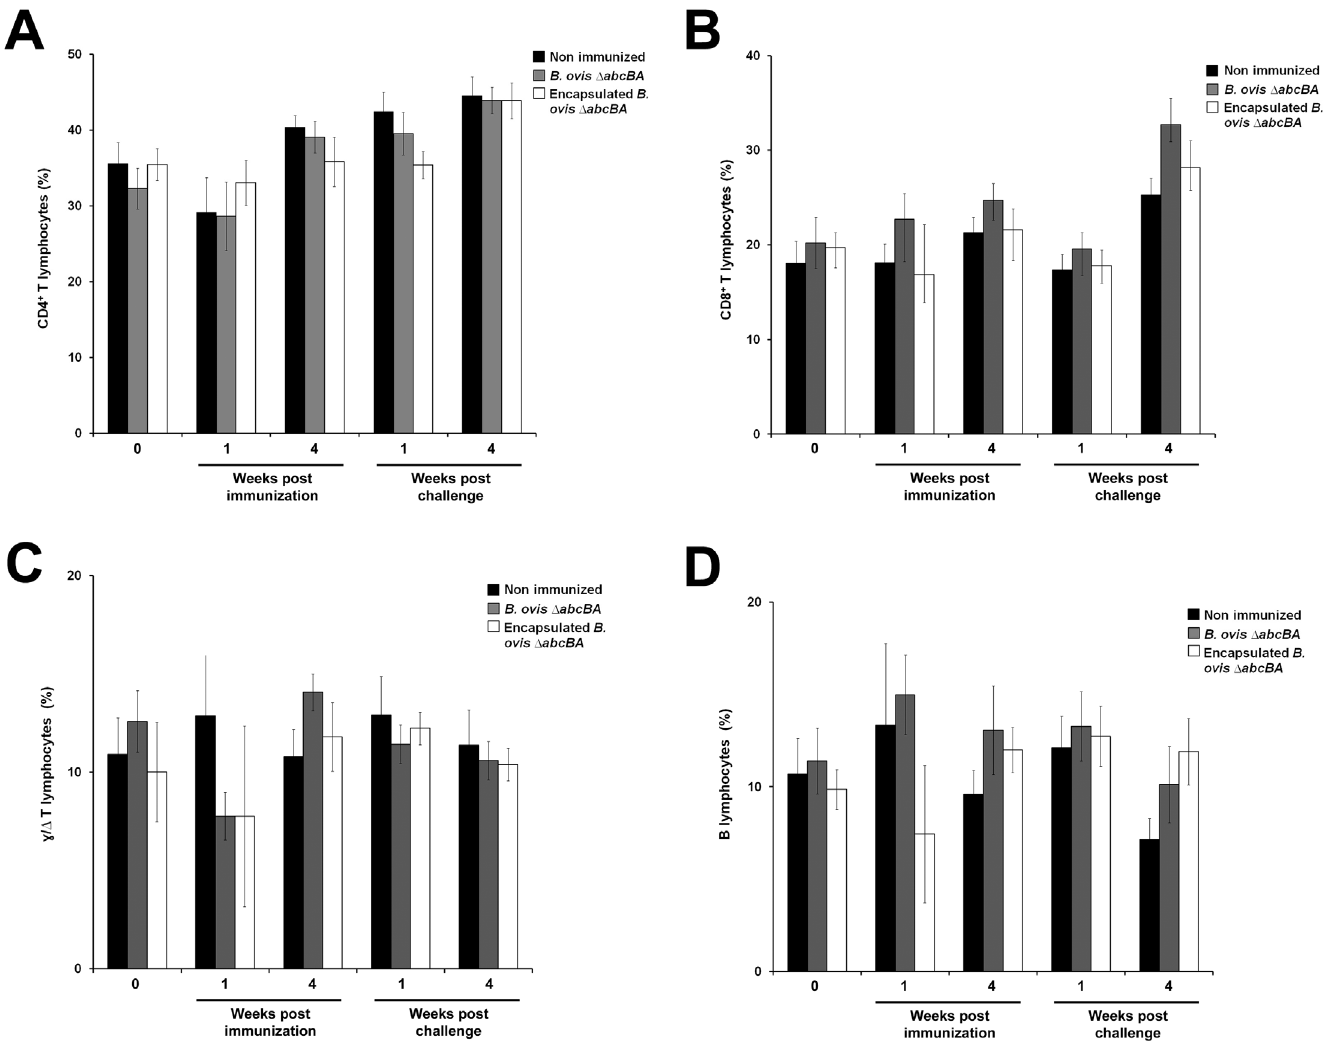
Fig 4. Peripheral blood leukocyte immunophenotyping of non immunized rams, and rams immunized with encapsulated or non encapsulated B . ovis Δ abcBA . Samples were obtained prior to immunization, 1 and 4 weeks after immunization, and 1 and 4 weeks after challenge. (A) CD4 + T lymphocytes, (B) CD8 + T lymphocytes, (C) γ / Δ T lymphocytes, and (D) B lymphocytes. The number of weeks before and after challenge is indicated in the x axis. Data represents mean and standard